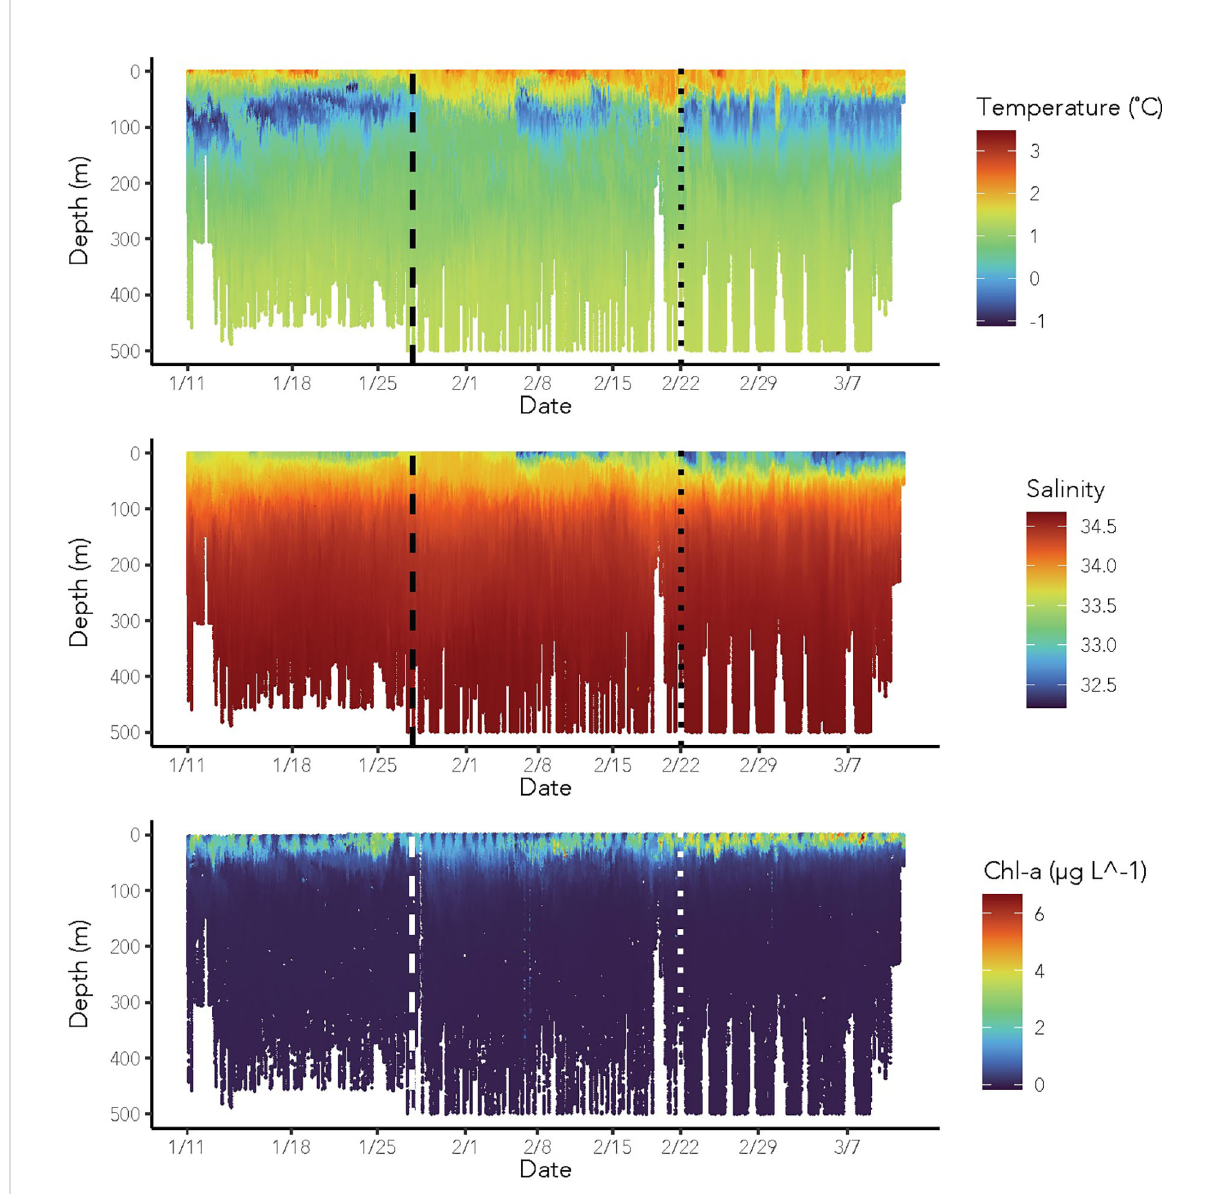
FIGURE 3 Temperature (°C, top panel), salinity (middle panel), and chl- a (µg L -1 , bottom panel) pro fi les obtained within the top 500 m of the water from glider-borne sensors between January 11 th and March 9 th , 2020. Dashed black lines in each panel represent the transition date between early and mid-season. Dotted black lines in each panel represent the transition date between mid- and late